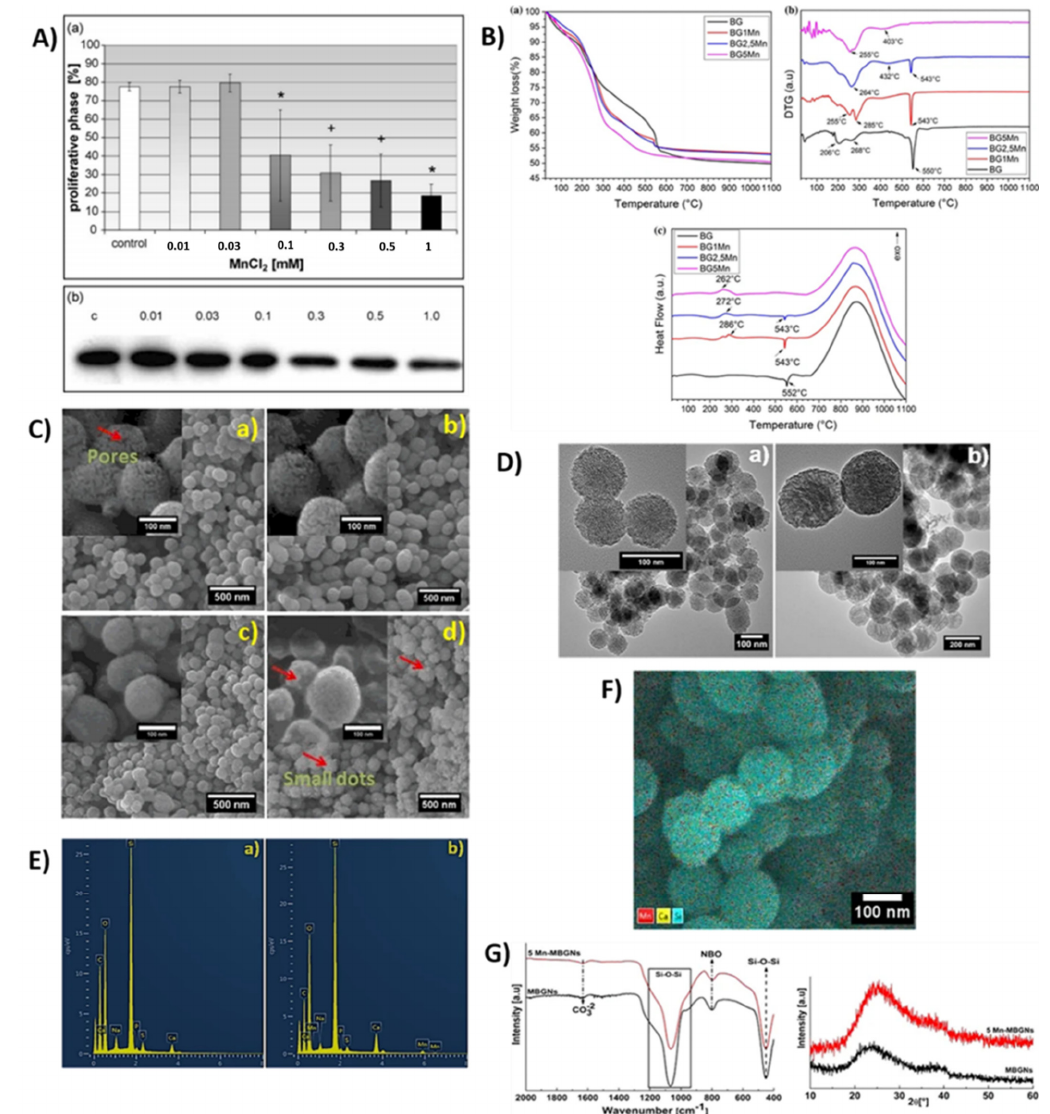
Figure 17. ( A ) shows the proliferation of osteoblast cells treated with varying concentrations of MnCl2. Manganese ions within the range of 0.1 mM to 1.0 mM prevent osteoblast proliferation. After 24 h, the cell cycle’s proliferative step (S+G2/M) is greatly decreased (flow cytometry, U-test, * p = 0.05, + p = 0.01, n = 8). Adapted from [279]. Reproduced with permission from Elsevier. ( B ) shows ( a ) thermogravimetric analysis (TGA), ( b ) derivative thermogravimetric (DTG), and ( c ) differential scanning calorimetry (DSC) of bioactive glasses. Adapted from [280]. ( C ) shows SEM images depicting the morphology of the synthesized BG particles: ( a ) MBGNs, ( b ) 3 Mn-MBGNs, ( c ) 5 Mn-MBGNs, and ( d ) 7 Mn-MBGNs. The bar on the micrograph is 100 nm. ( D ) shows TEM images of ( a ) MBGNs and ( b ) 5 Mn-MBGNs. The bar on the micrograph is 500 nm. ( E ) shows EDX spectra of the synthesized BG particles ( a ) MBGNs and ( b ) 5 Mn-MBGNs. The presence of an Mn peak in addition to the Ca, P, and correspond responds to the addition of Mn in MBGNs. ( F ) shows EDX mapping analysis of 5 Mn-MBGNs showing that Ca (yellow), Mn (red), and Si (blue) are uniformly distributed in the nanoparticles. ( G ) shows XRD analysis (right) and FTIR spectra (left) of the synthesized BG nanoparticles doped with various concentrations of Mn. XRD analysis revealed the amorphous structure of MBGNs and 5 Mn-MBGNs indicated by the broad hump in the range of 20–34 ◦ . Adapted from